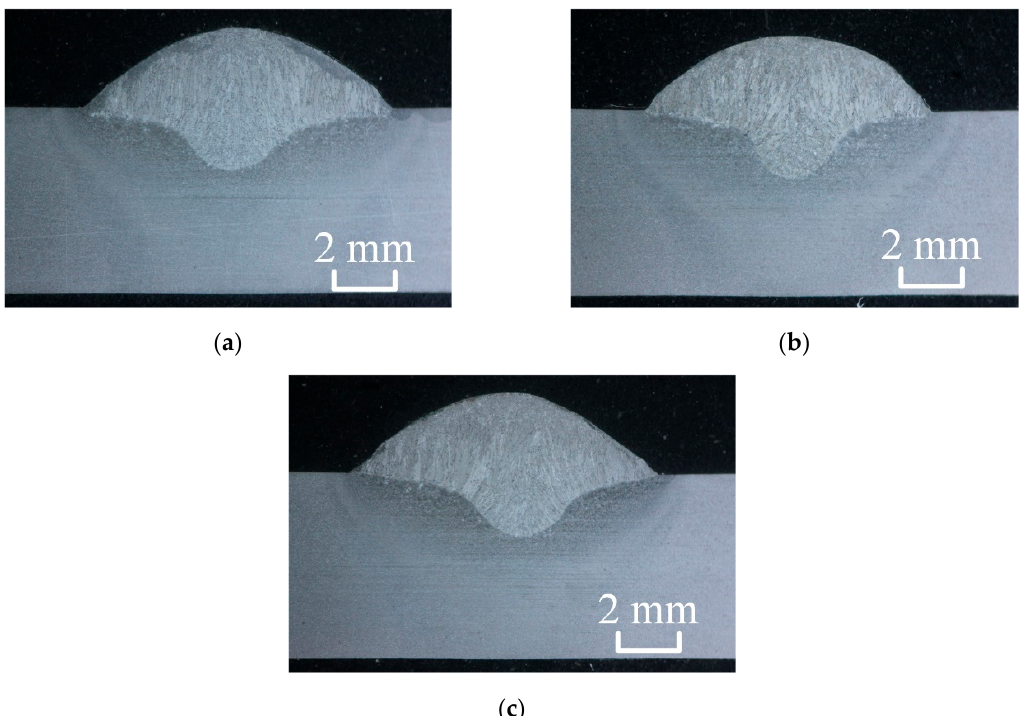
Figure 4. The cross-section appearance of beads with three typical modes of droplet transfer: ( a ) one drop per multiple pulses (ODMP); ( b ) one drop per pulse (ODPP); ( c ) multiple drops per pulse (MDPP).